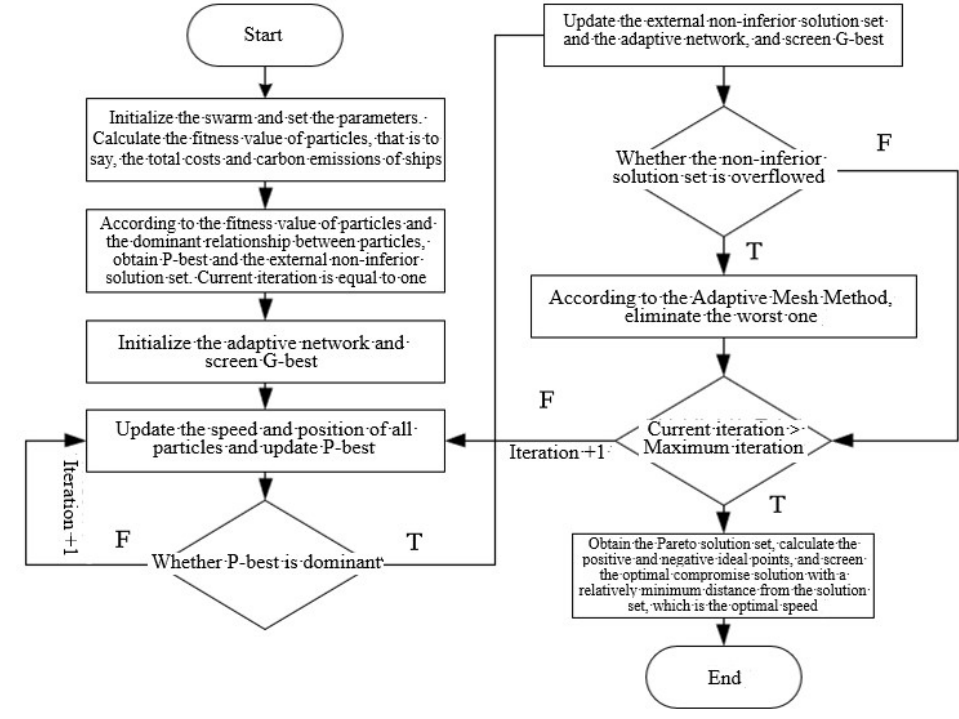
Figure 3. Flow chart of the solution.